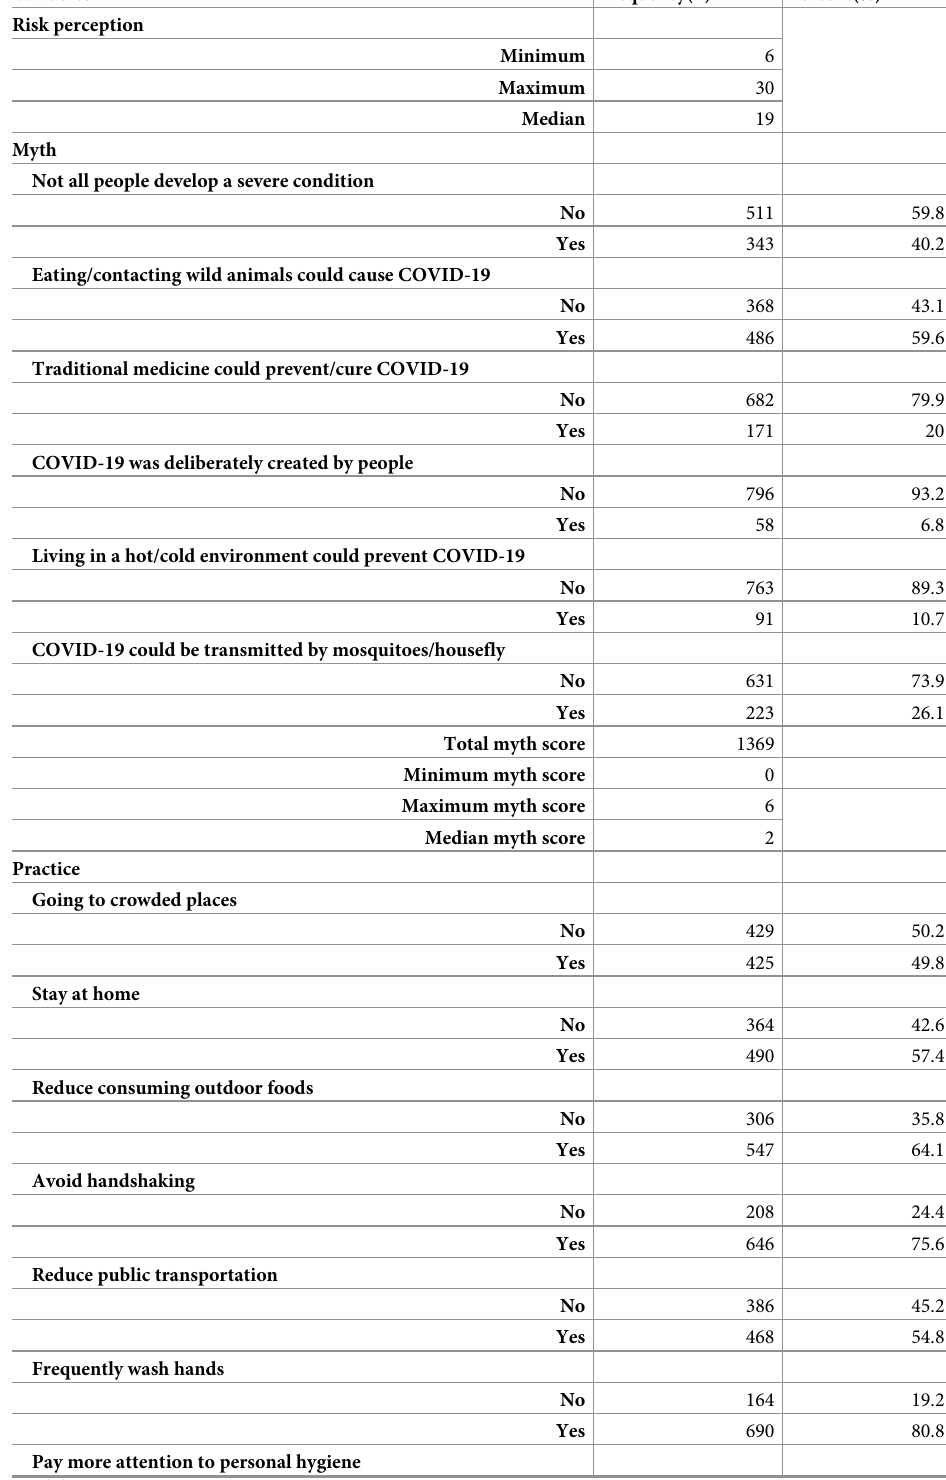
Table 2. Distribution of risk perception, community myth, and preventive practices towards